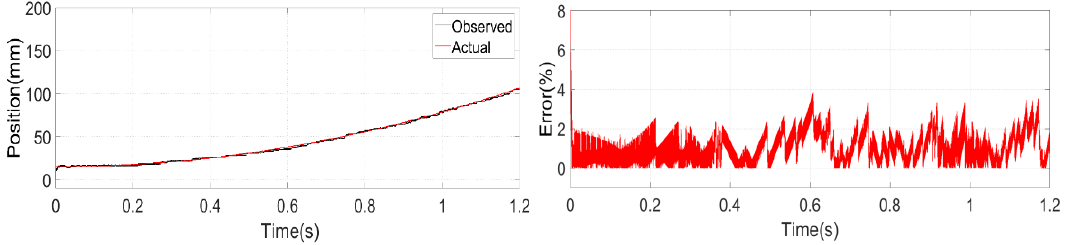
Figure 12. Position observation results at an injection voltage of 100 V without a filter.